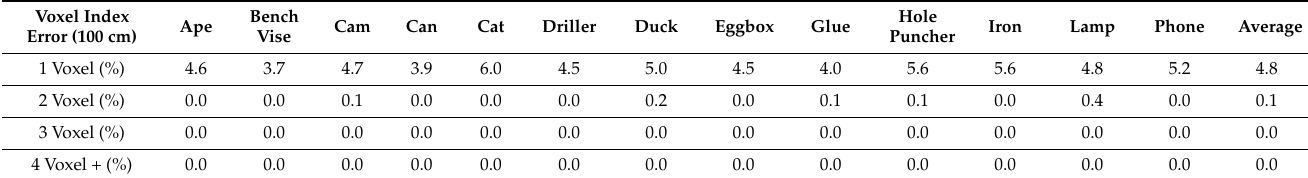
Table 6. Distance error comparison for voxel size (100